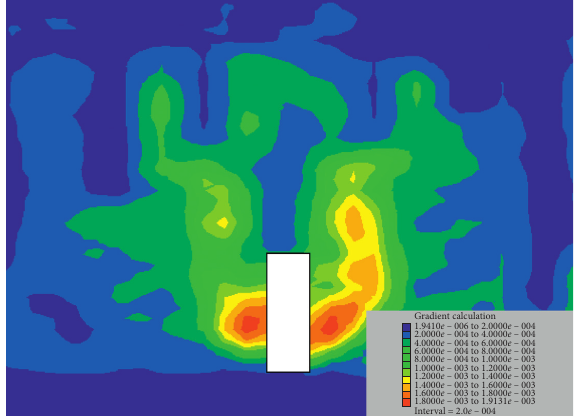
Figure 7: Cloud of the maximum shear strain